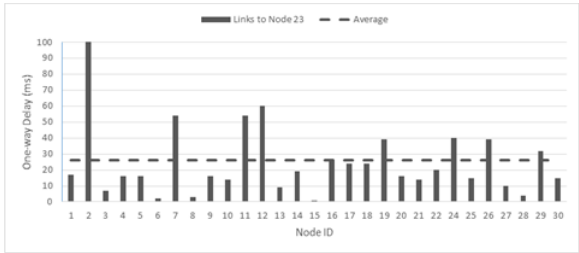
Fig. 20. Link Latencies for Links Connecting Node 23 of 30 The resulting average delay for each node for different values of destination nodes (5, 10, 15, 20, 25) are shown in Figures 9 – 13. The vertical error bars on the measured averages represent the standard deviation in the sampled data set. We observe that the measured versus calculated values match quite well with a small number of destination